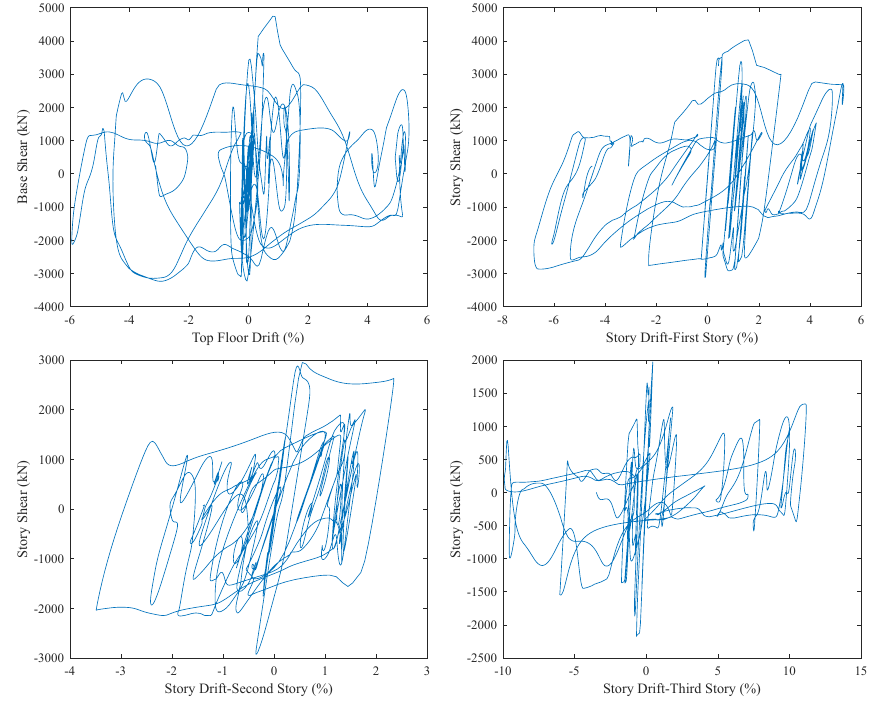
Figure 11. Hysteretic behavior of the cross-braced